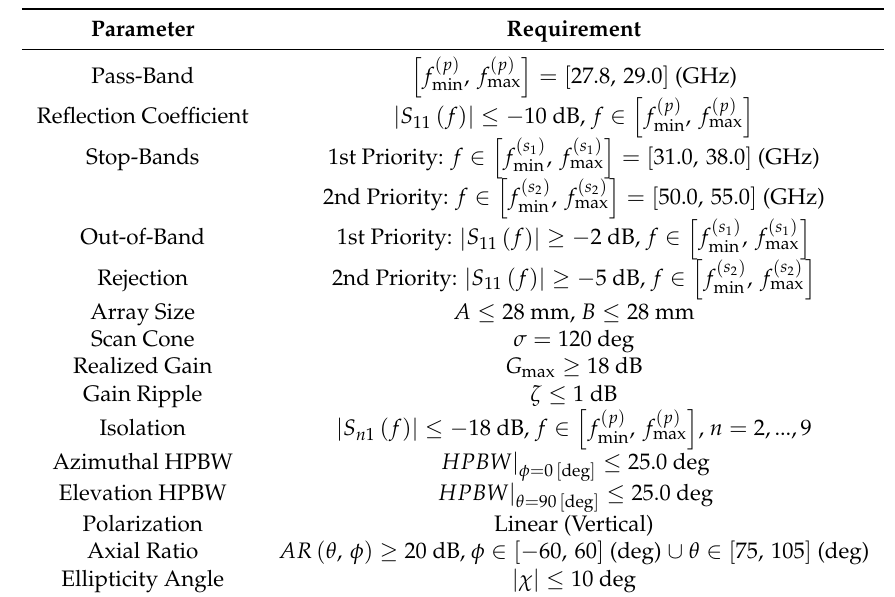
Figure 2. Geometry of the HDI-based 5G filtering patch radiator: ( a ) 3D and ( b ) top views. Table 1. 5G array design—Performance and geometric/mechanical design